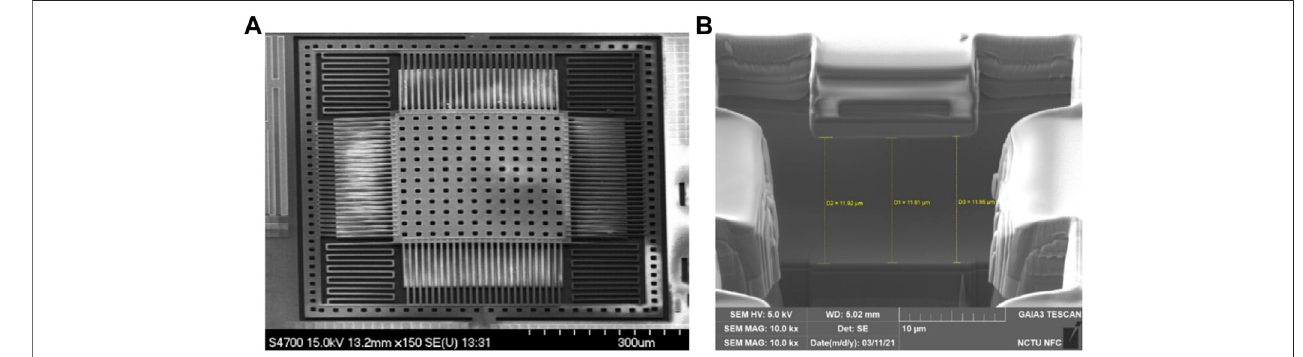
FIGURE 9 | Released device, (A) SEM micrograph, (B) FIB cut.